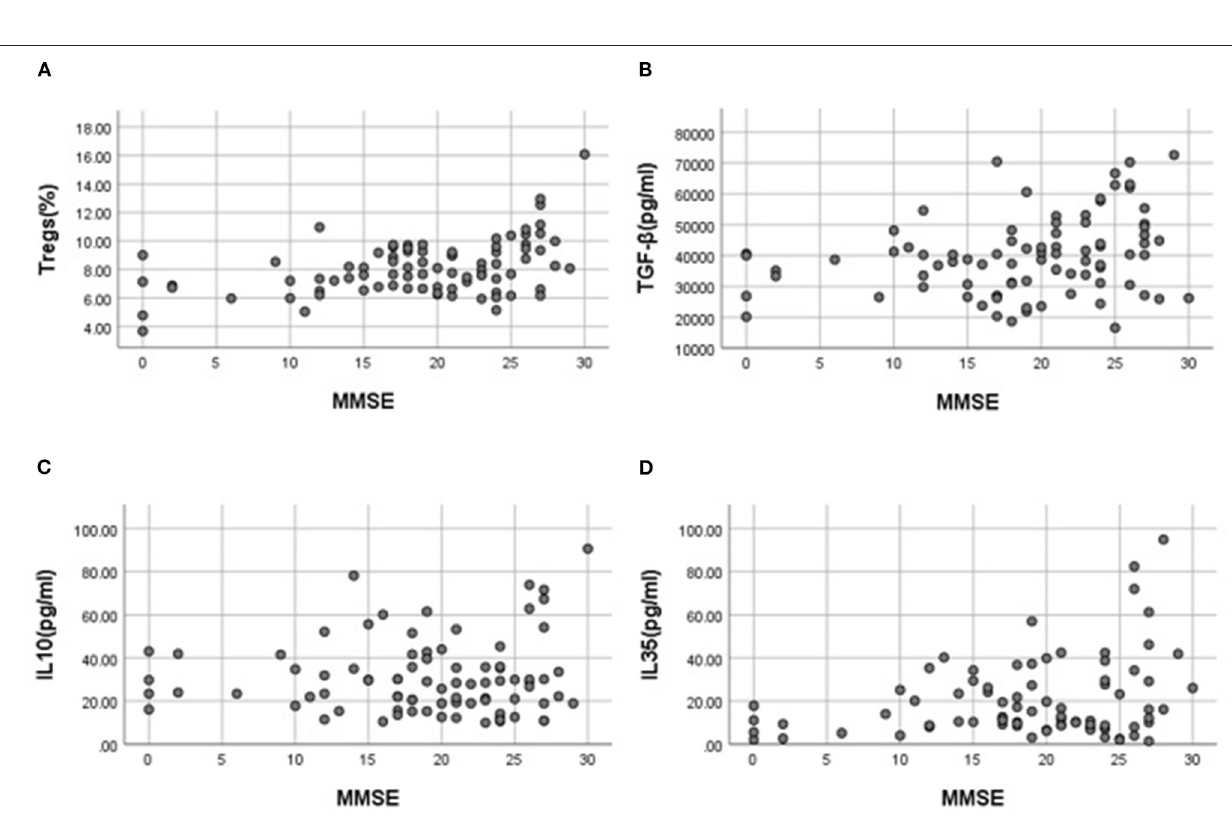
FIGURE 2 | Scatter plots show correlation between regulatory T cells (Tregs), transforming growth factor β (TGF- β ), interleukin 10 (IL10), interleukin 35 (IL35), and cognitive function after controlling for age in MCI and AD dementia patients. (A) Correlation between percentage of CD 4 + CD 25 + CDl27 low / − Tregs and Mini-mental state evaluation (MMSE) scores (the partial correlation coefficient was 0.445, P-value was 0.001). (B) Correlation between concentration of TGF- β and MMSE scores ( P > 0.05). (C) Correlation between concentration of IL10 and MMSE scores ( P > 0.05). (D) Correlation between concentration of IL35 and MMSE scores (the partial correlation coefficient was 0.285, P-value was